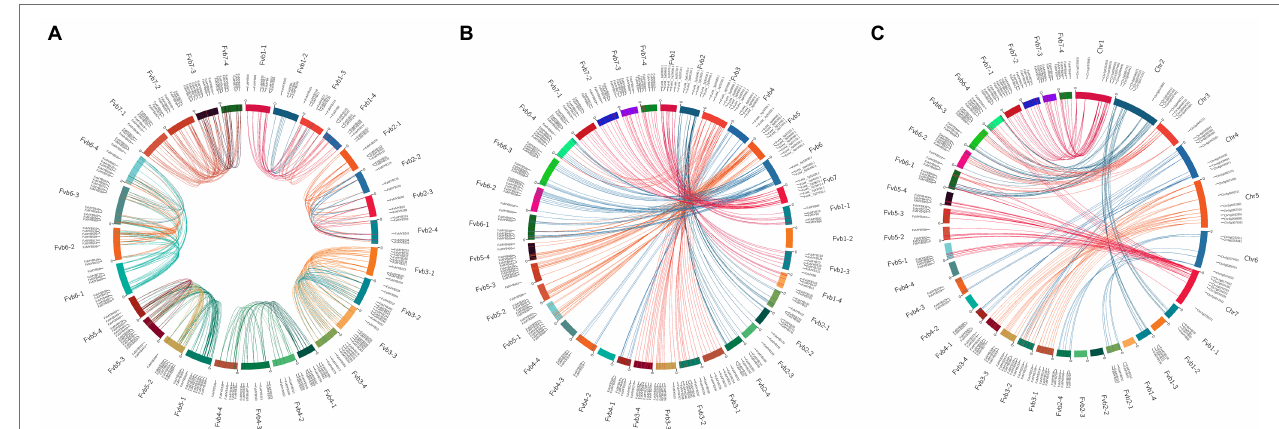
FIGURE 3 | Collinearity analyses of R2R3-MYB genes in the F. × ananassa genome, and among F. × ananassa , F. vesca , and R. chinensis genomes. (A) Collinearity analysis of R2R3-FaMYBs in F. × ananassa ; (B) interspecific collinearity analysis of R2R3-MYBs between F. × ananassa and F. vesca ; (C) interspecific collinearity analysis of R2R3-MYBs between F. × ananassa and R. chinensis . Outer boxes represented chromosome numbers. Colored lines in boxes indicated the location of R2R3-MYB genes in each chromosome. Gene pairs with a syntenic relationship are joined by colored lines.